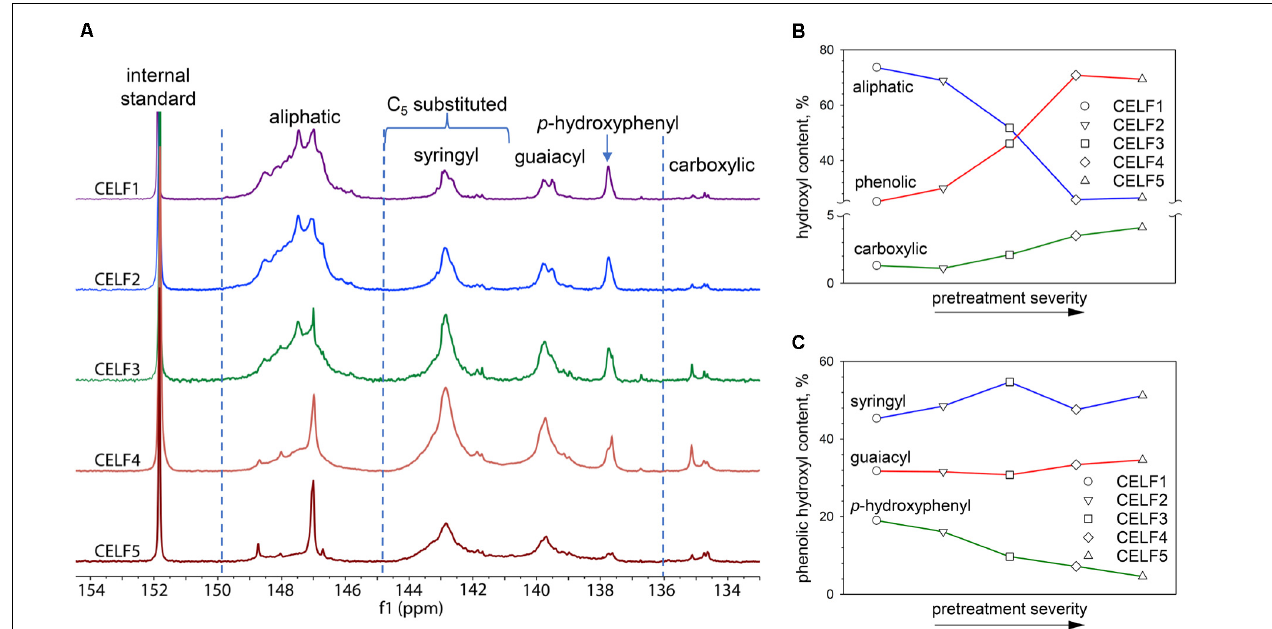
FIGURE 2 | (A) Quantitative 31 P NMR spectra of TMDP phosphitylated CELF lignin samples. (B) The relative quantities (%) of aliphatic, phenolic and carboxylic hydroxyl groups in total lignin hydroxyl groups. (C) The relative contents (%) of syringyl, guaiacyl and p -hydroxyphenyl hydroxyl groups in total lignin phenolic hydroxyl